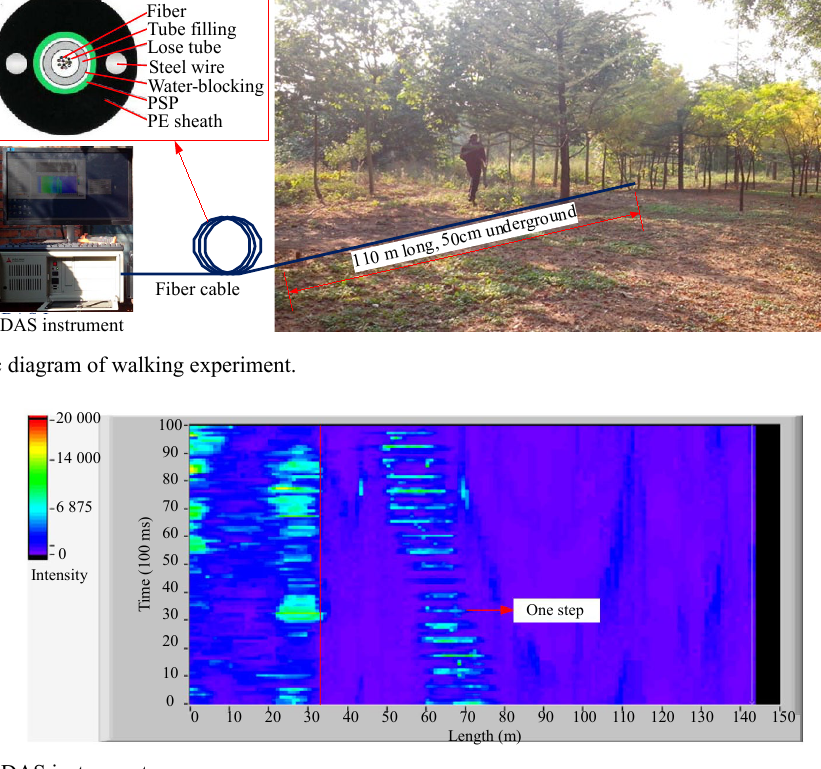
Fig. 8 Output of DAS instrument